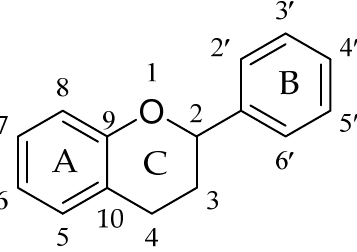
Figure 2. Basic skeleton and numbering system of flavonoids.